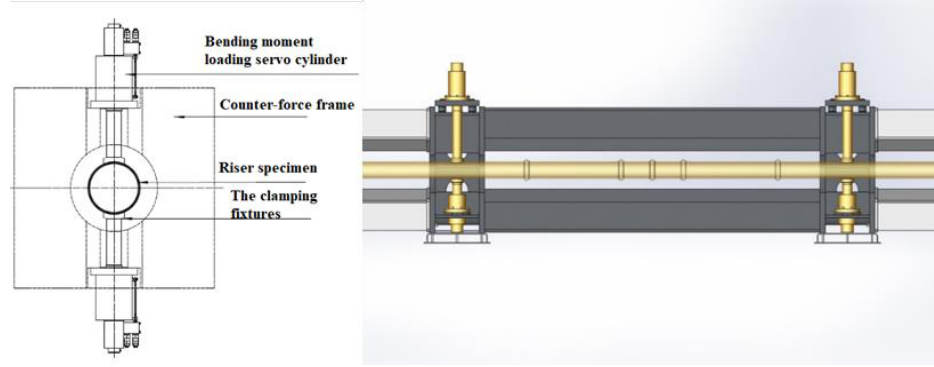
Figure 12. Moment loading device.